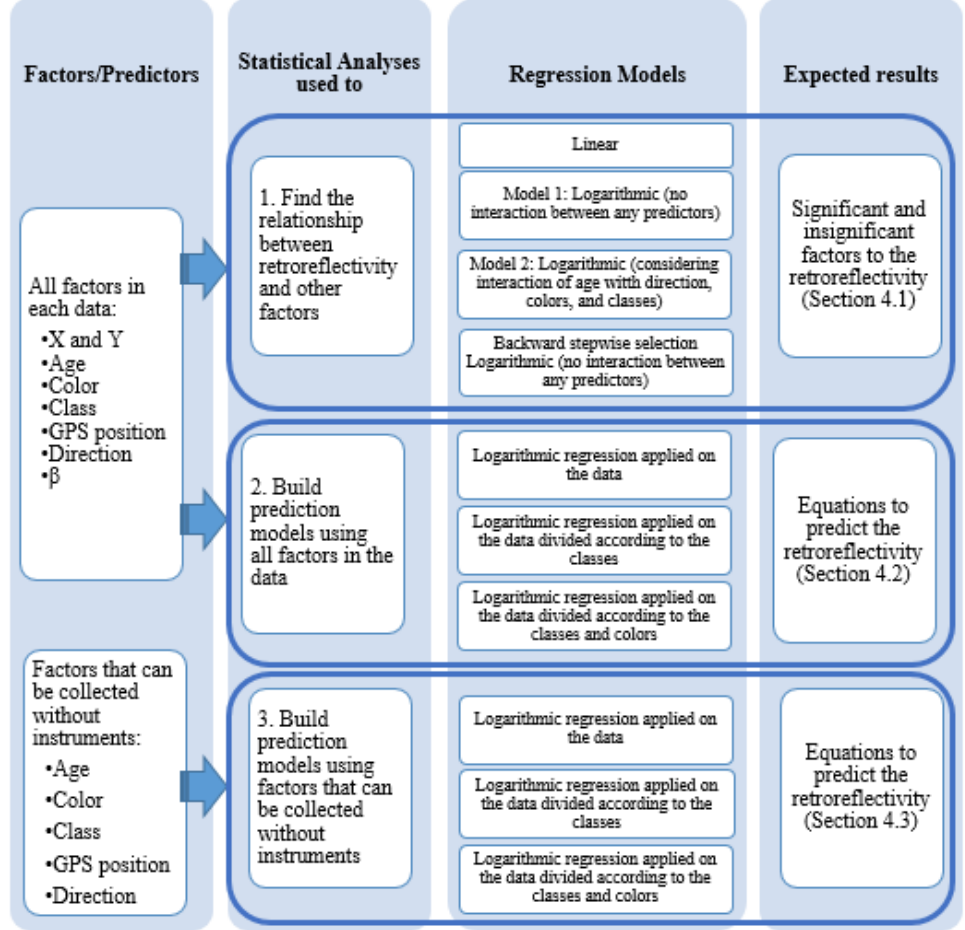
Figure 5. Statistical analysis design to determine those factors/predictors that significantly affect retroreflectivity and also predict retroreflectivity.